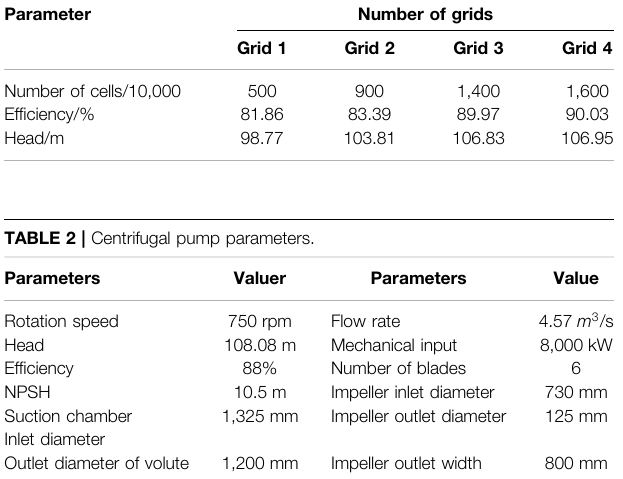
TABLE 1 | Grid independence analysis.